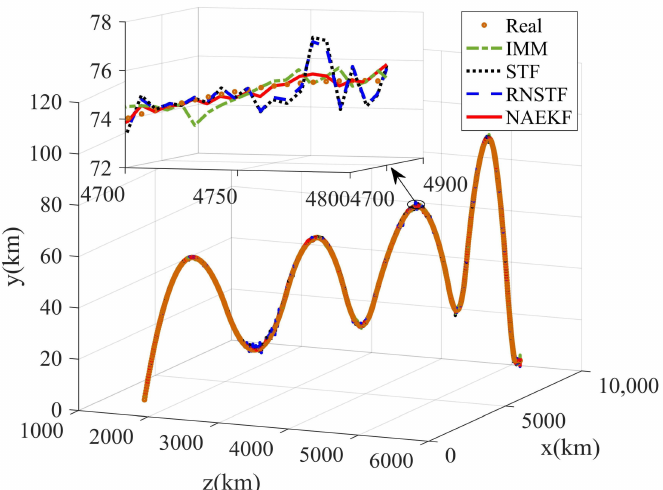
Figure 18. Estimated trajectories.